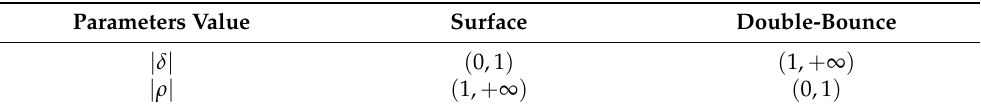
Table 1. Connections between orthogonal scattering models and surface and double-bounce scatter- ing models.